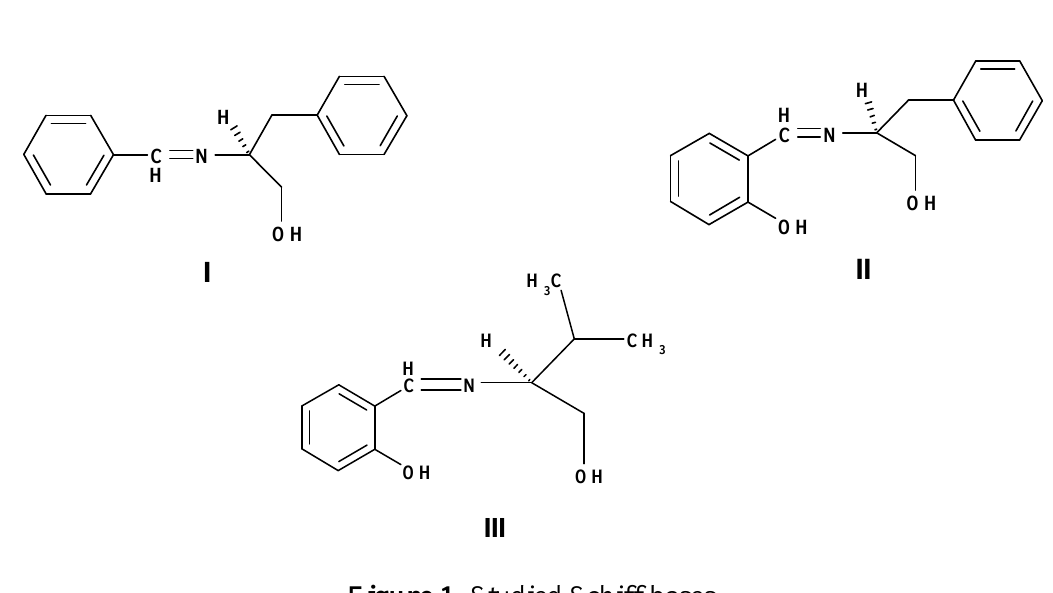
Figure 1. Studied Schiff